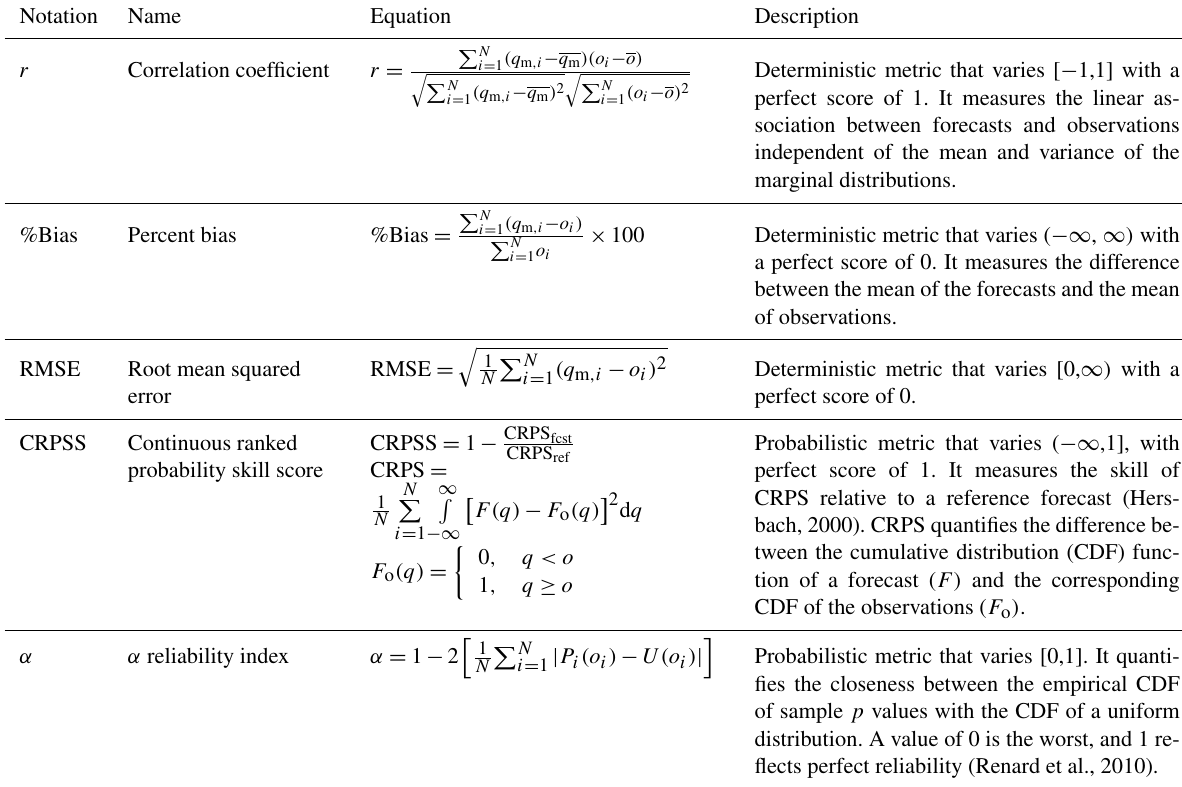
Table 3. Performance metrics used to assess and compare seasonal streamflow forecasting